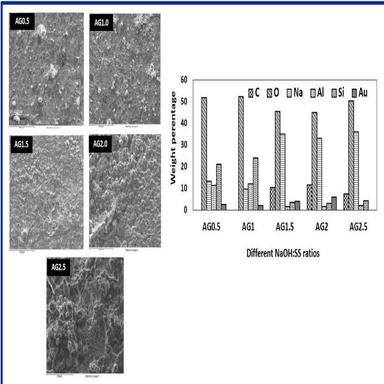
FESEM micrographs with EDX analysis of different geopolymer coating compositions.